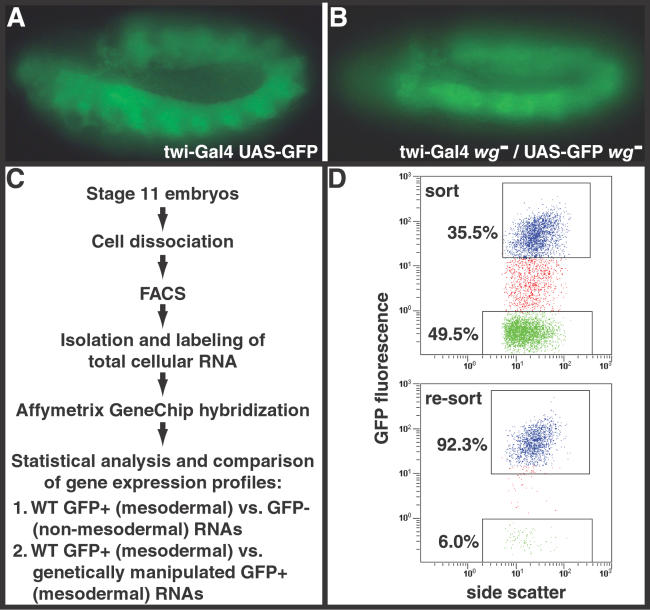
Experimental Strategy for Transcriptional Profiling of Purified Embryonic Mesodermal Cells(A) Embryos transgenic for Gal4 under the control of the twi promoter and GFP under UAS control express GFP specifically in mesodermal cells.(B) If twi-Gal4 and UAS-GFP transgenes are maintained on mutant chromosomes, only homozygous mutant mesoderm expresses GFP when the resulting flies are mated.(C) Overview of the workflow to obtain genomewide expression information on mesodermally enriched and genotype-responsive genes.(D) A representative FACS experiment, showing initial sorting of all cells from wild-type embryos (top; upper box represents GFP-positive sort window [blue], lower box represents GFP-negative sort window [green]) and resorting of the purified cell population (bottom). Sorting parameters routinely achieved greater than 90% pure GFP-positive cells.